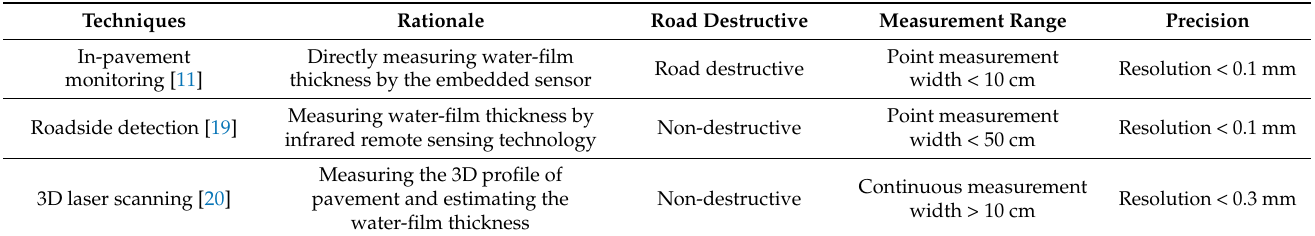
Table 1. Comparison between different water-film thickness measurement techniques.